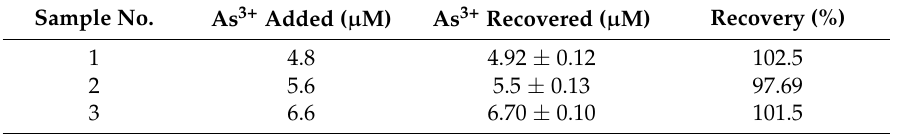
Table 2. Determination of As 3+ in real ground water samples.